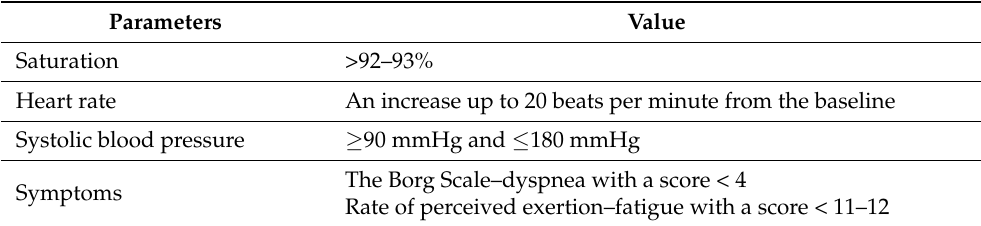
Rate of perceived exertion–fatigue with a score <